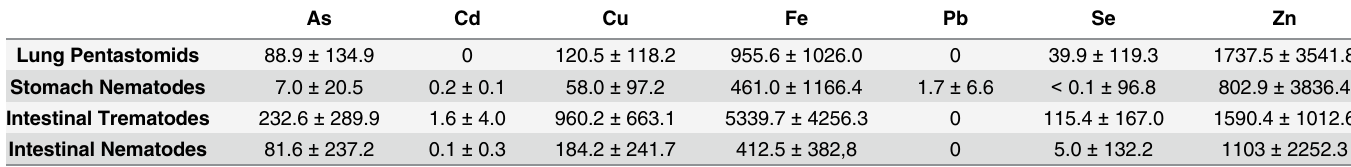
Table 3. Average heavy metal concentrations (mg/kg ± standard deviation) for different parasite groups.